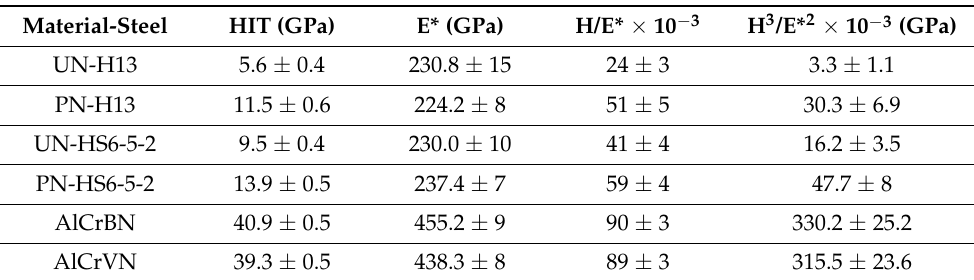
Table 6. Ratio H/E * and H 3 /E * 2 of the tested